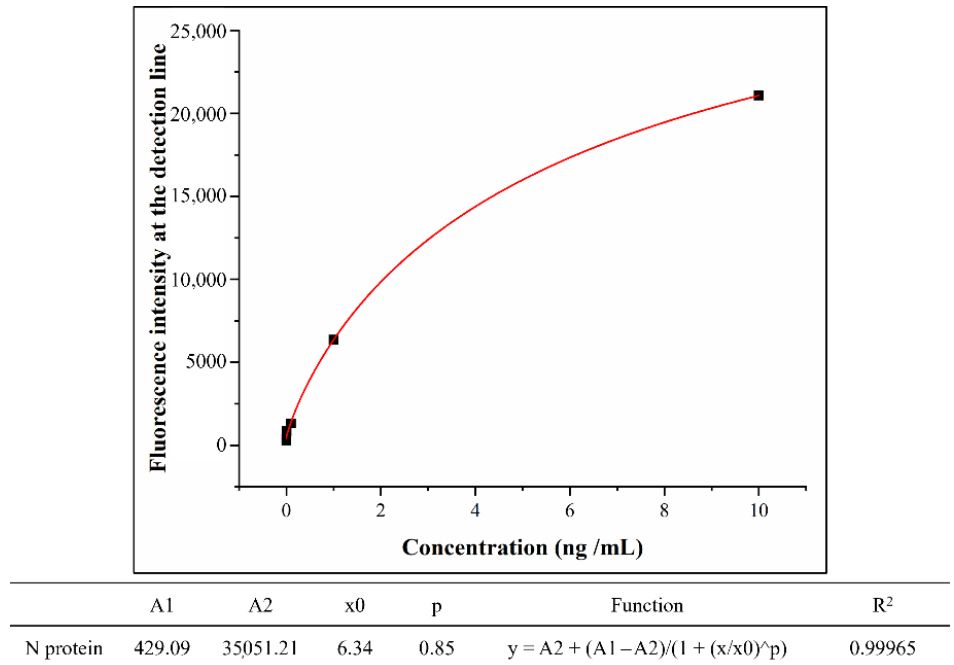
Figure 9. The COVID-19 N protein LFIA strips parameters and function of fitting nonlinear equation between concentration and fluorescence intensity of N proteins.